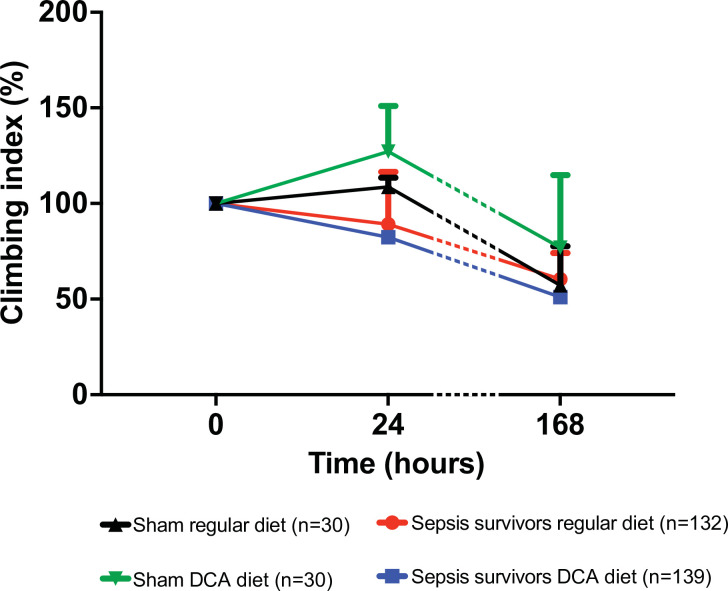
Geotaxis among sepsis survivors is not improved by DCA.Despite lifespan advantage provided by the 1-week exposure to DCA, geotaxis–a composite index of locomotor performance- did not improve negative geotaxis among survivors of sepsis.